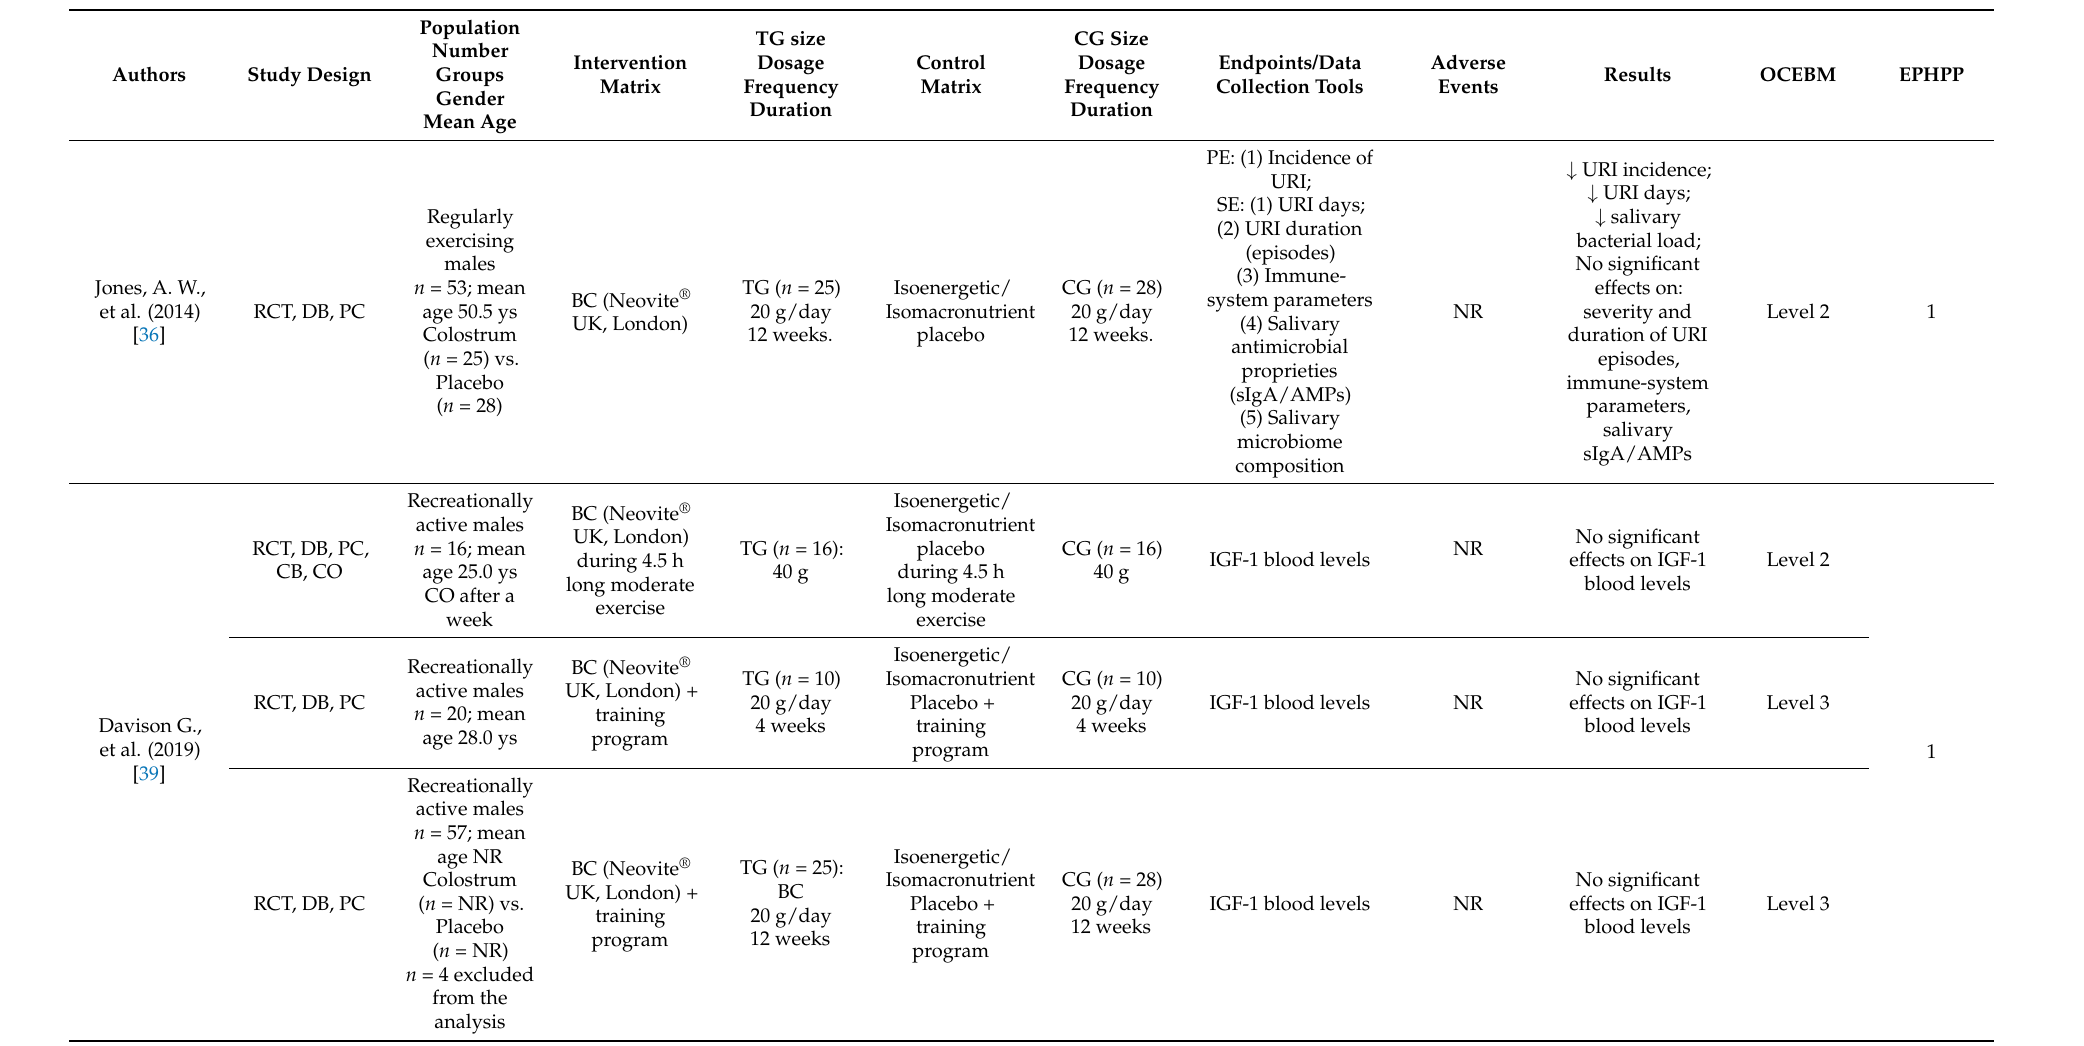
Table 3. BC as dietary supplement in the sporting